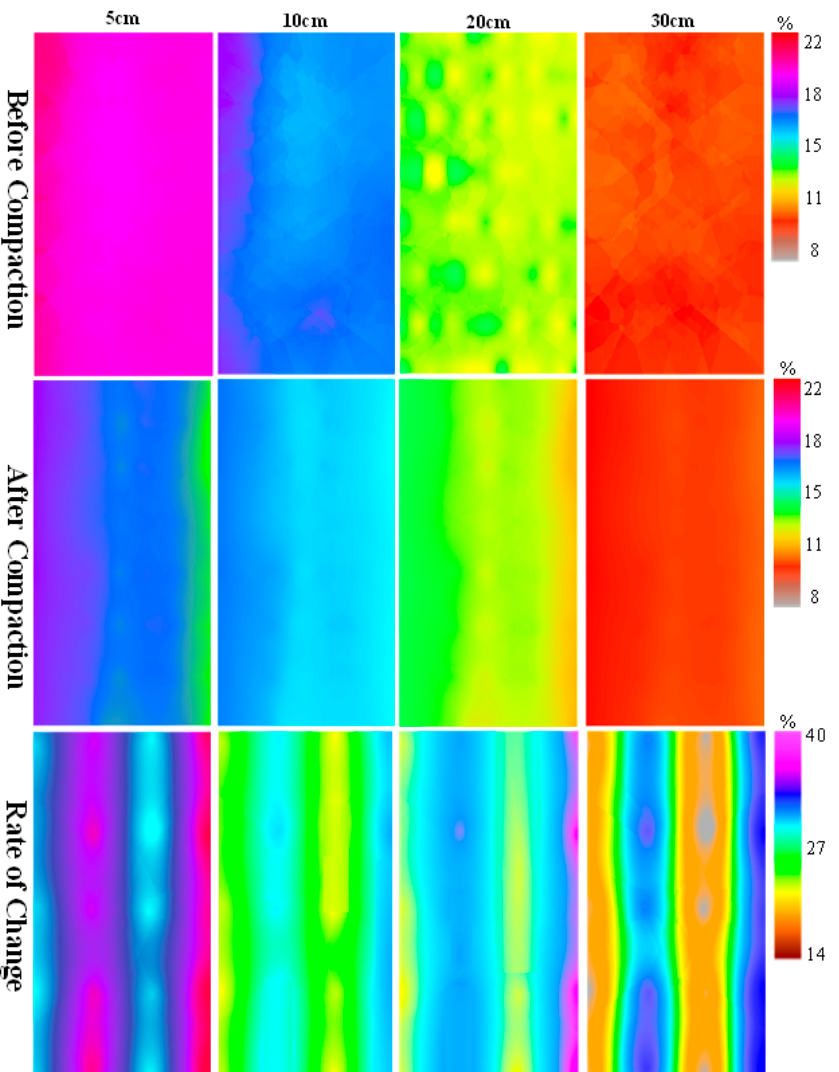
Figure 14. Lateral spatial distribution of soil porosity at each depth before and after compaction .